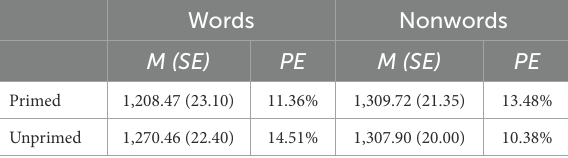
TABLE 1 Mean reaction times (in ms) and percent errors (PE) for words and nonwords by priming for Experiment